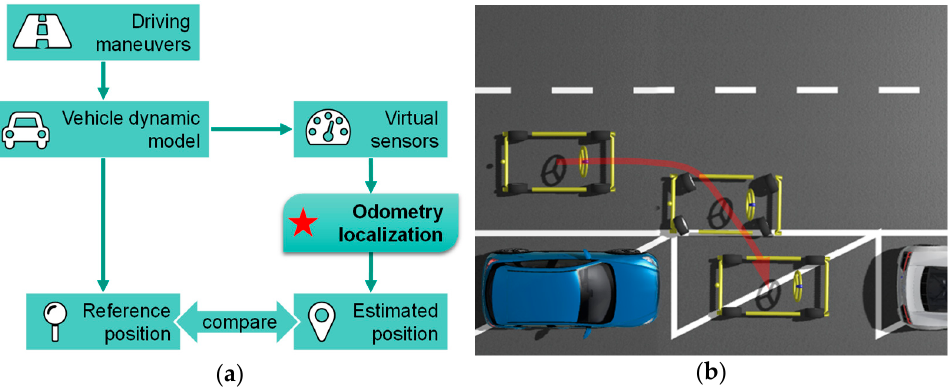
Figure 16. ( a ) Validation process in simulation environment; ( b ) virtualization of omnidirectional parking maneuver in simulation environment.